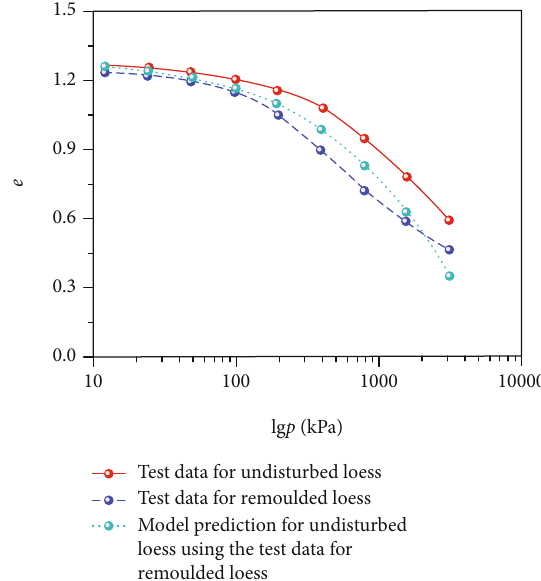
Figure 2: Comparison of the compression lines obtained by tests and model